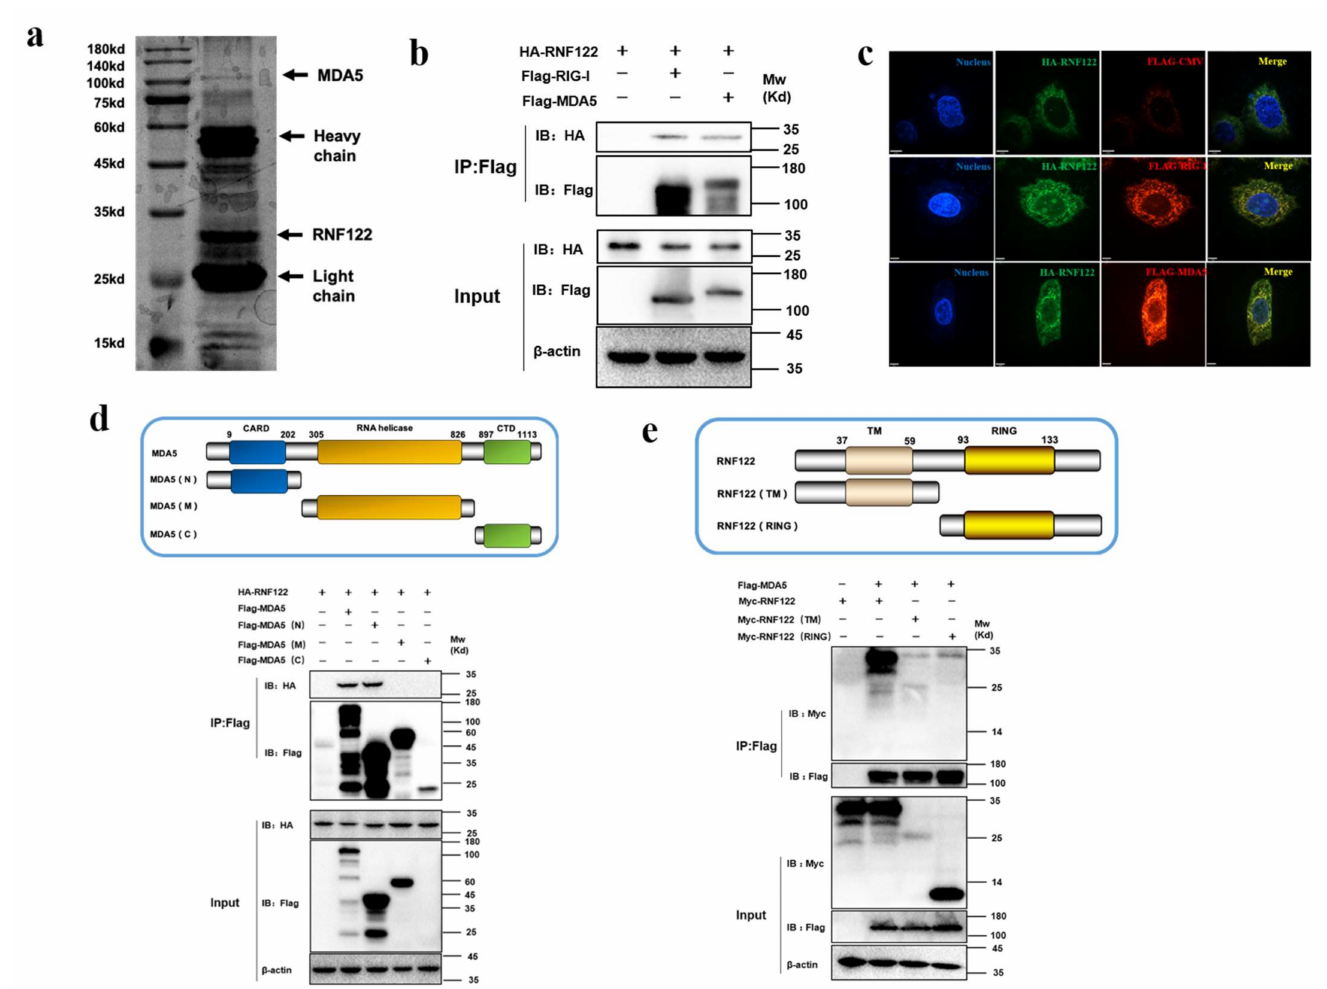
Figure 9. Interaction between porcine RNF122 and MDA5 molecules. ( a ) HEK293T cells were co- transfected with Flag-RNF122, 24 h after transfection, Flag Beads were used for protein enrichment, and further detected by Western blotting. Then the gel was stained with silver using a ProteoSilver Silver Stain Kit (Solarbio Life Sciences). ( b ) HEK293T cells were co-transfected with HA-RNF122 and Flag-RIG-I, Flag-MDA5 or Flag-CMV. Flag Beads were used for CO-24 h after transfection IP, and further detected by Western blotting with an anti-Flag antibody and an anti-HA antibody, respectively. ( c ) HeLa cells were placed on coverslips in 12-well plates and co-transfected with the HA-RNF122 and Flag-RIG-I, Flag-MDA5 or Flag-CMV, respectively. Fixed double-stained with a mouse anti-HA mAb and a rabbit anti-Flag antibody, and followed by FITC-conjugated anti-mouse IgG (green) and PE-conjugated anti-rabbit IgG (red). Nuclei were stained with DAPI (blue). Fluorescence confocal microscopy (UltraView Vox, PerkinElmer, Waltham, MA, USA) was used to detect the co-location. ( d ) HEK293T cells were co-transfected with HA-RNF122 and Flag-MDA5, Flag-MDA5 (N), Flag- MDA5 (M), Flag-MDA5 (C)or Flag-CMV. Flag Beads were used for CO-IP 24 h after transfection, and further detected by Western blotting with an anti-Flag antibody and an anti-HA antibody, respectively. ( e ) HEK293T cells were co-transfected with Flag-MDA5 and Myc-RNF122, Myc-RNF122 (TM), Myc- RNF122 (RING) or Myc-CMV. Flag Beads were used for CO-IP 24 h after transfection and further detected by Western blotting with an anti-Flag antibody and an anti-Myc antibody,